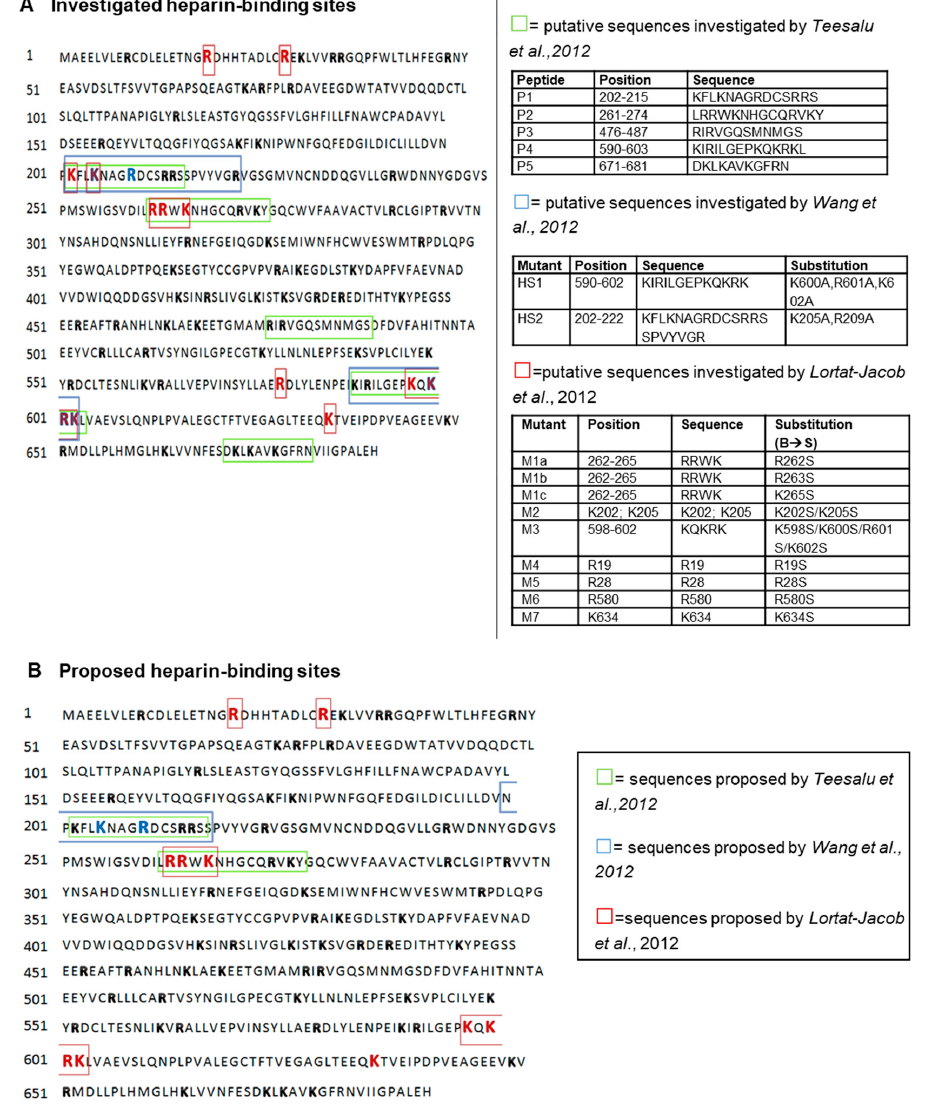
Figure 2. Investigation of the heparin binding site(s) of TG2. ( A ) Putative heparin binding sites independently investigated by three research groups [10,180,181]. ( B ) Heparin binding regions mapped by the three groups [10,180,181]. Basic residues arginine (R) and lysine (K) are highlighted in bold; the amino acids mutated by site directed mutagenesis in the cited studies are highlighted in blue (for Wang et al, 2012) and/or red (for Lortat-Jacob et al., 2012).